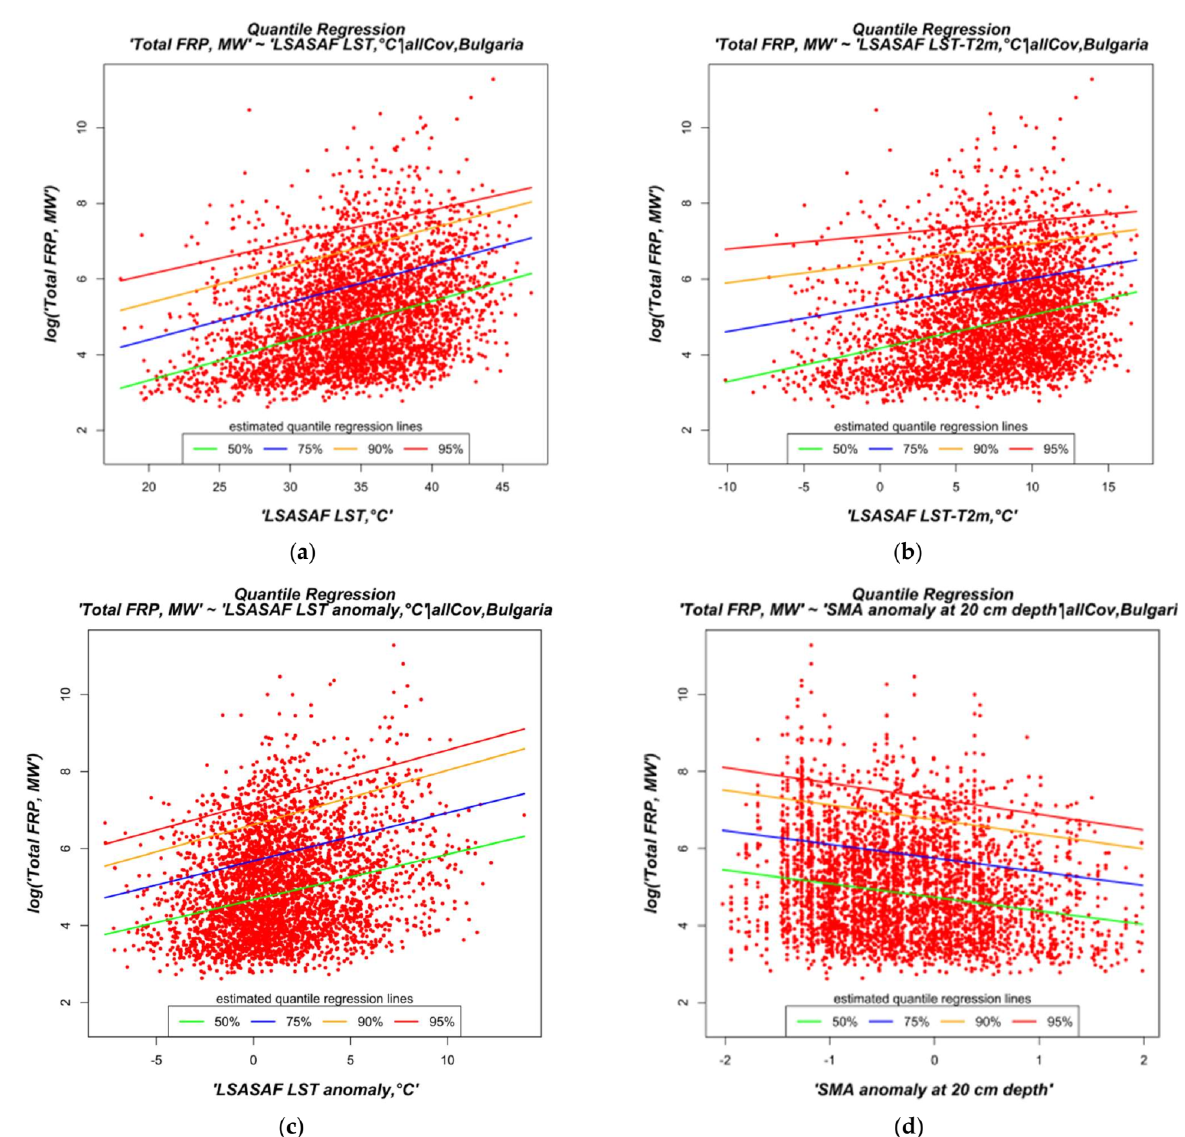
Figure 8. Quantile regression of the total energy released by biomass burning (all land cover types) in Bulgaria (June–September 2007–2018): log (Total FRP-Pixel, MW) vs. ( a ) LSASAF LST 0900 UTC; ( b ) (LSASAF LST-T2m) temperature difference; ( c ) LSASAF LST anomaly (2007–2018); ( d ) SMAI anomaly at 20 cm soil depth. Regression lines for 50%, 75%, 90%, and 95% quantile are